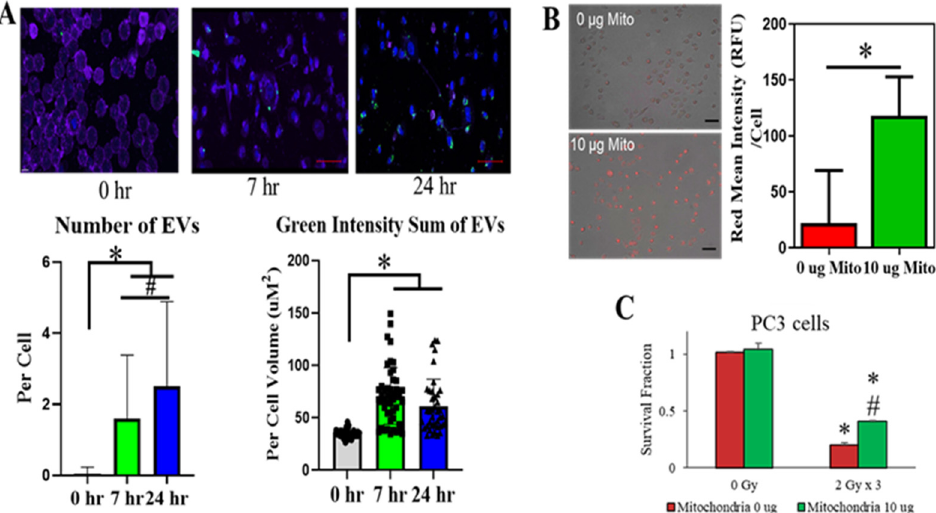
Figure 8. Uptake of mitochondria particles and increase in surviving fraction after RT in PC3 cells. ( A ) EV particles labeled with GFP were uptake by PC3 cells after RT. Green = EV, Purple = plasma membrane, Blue = Nucleus. Number of EVs (based on green GFP) and GFP intensity of EVs were quantify using Imaris software (* p -value < 0.0001, # p -value = 0.05). ( B ) Isolated external mitochondria (red) were uptake by PC3 after RT. Intensity of RFP represent amount of mitochondria in the cell. Circles, squares, and triangles represent individual data points of 0 h, 7 h, and 24 h respectively. ( C ) Colony survival assay of PC3 cells that uptake external mitochondria. * p -value < 0.05 when compared to 0 Gy. # p -value < 0.05 when compared to non-mitochondrial treatment.